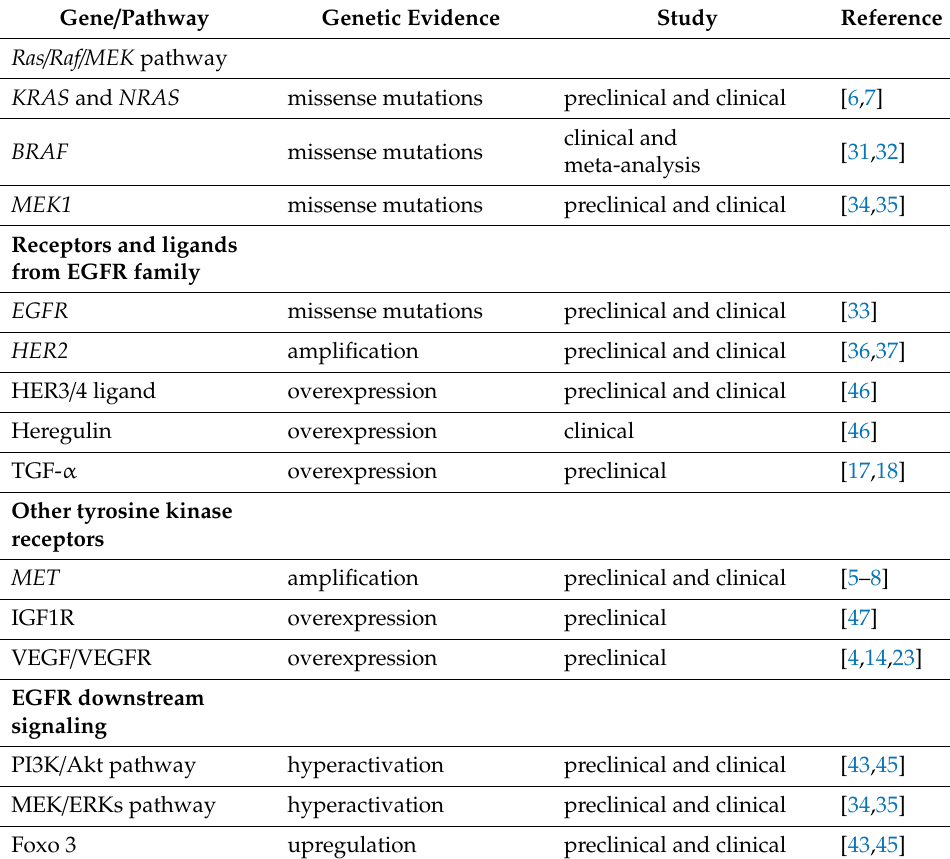
Table 3. Mechanisms of acquired resistance to anti-EGFR treatment in CRC patients. The main mechanisms involved in the generation of acquired resistance to anti-EGFR therapy are described. They are classified in subgroups according to the pathway(s) and type of